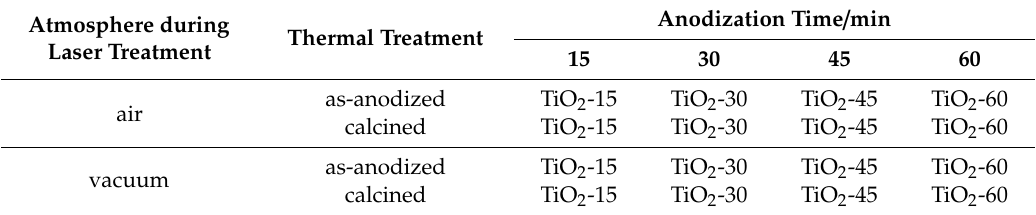
Table 1. Summarization of all obtained samples regarding anodization time, thermal treatment, and atmosphere during laser